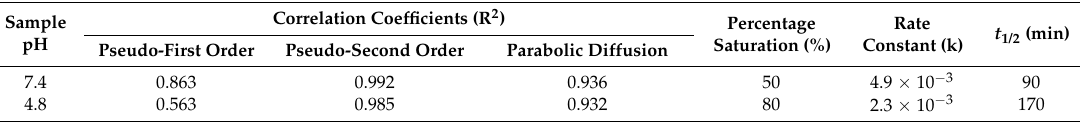
Table 1. Correlation coefficients (R 2 ), percentage saturation (%), rate constants (k), and half-life ( t 1/2 ) of protocatechuic acid release at pH 7.4 and 4.8 PBS from GAGPA as derived from the models.